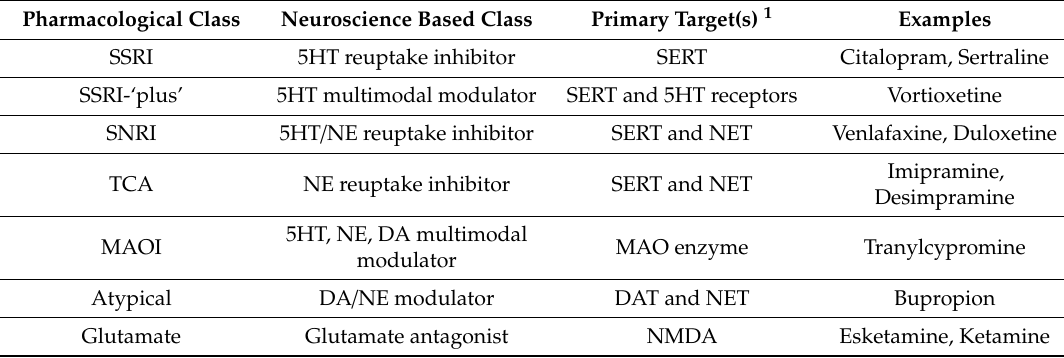
Table 1. Pharmacological Classes of Antidepressants.